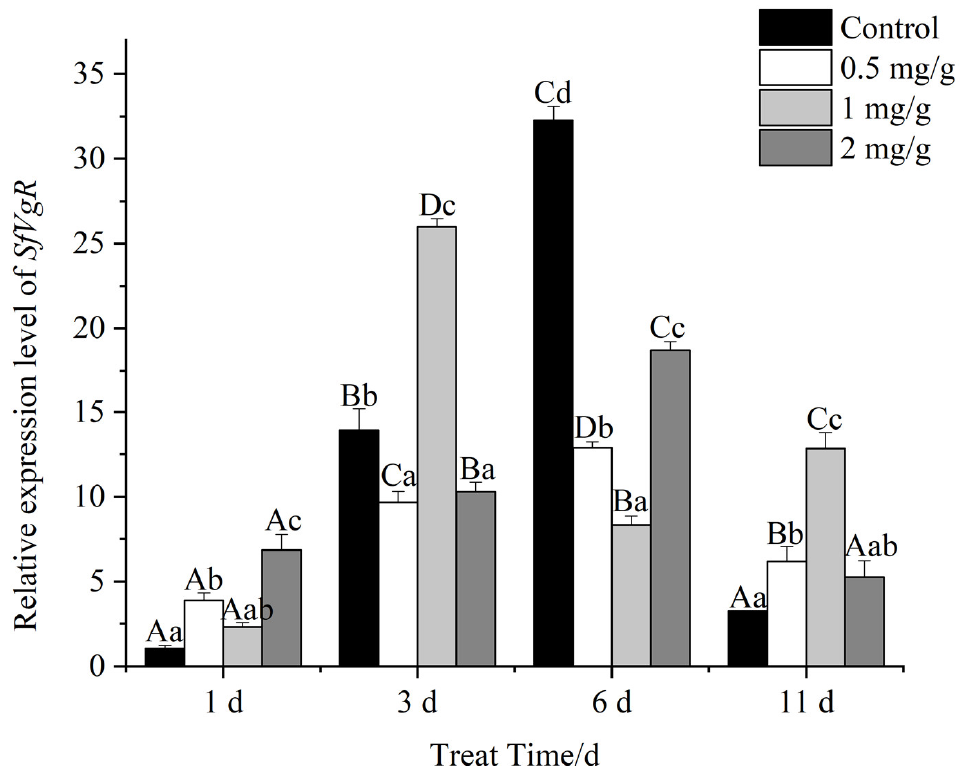
Figure 8. Relative expression levels of SfVgR in female adults of Spodoptera frugiperda at different developmental stages. Data are mean ± standard error. Different lowercase letters indicate that the expression levels of genes treated with different concentrations of GO at the same time are significantly different at p < 0.05 level as tested by Tukey’s HSD method. Different capital letters indicate highly significant differences in gene expression at different times when treated with the same concentration of GO at p < 0.01 level as tested by Tukey’s HSD method.